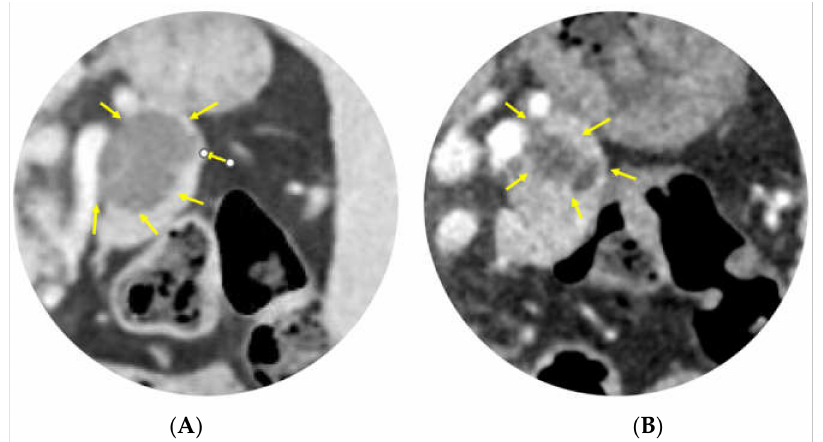
Figure 1. EUS-guided chemoablation with large surface area microparticle paclitaxel (LSAM-PTX) of a branch-duct IPMN. CT-Scan of the abdomen showing a decrease in the lesion size comparing ( A ) pre-ablation to ( B ) post-ablation after 2 injections of LSAM-PTX by